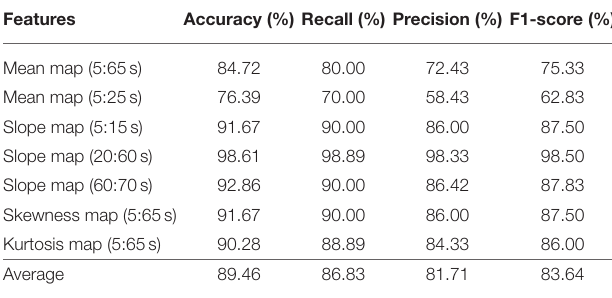
TABLE 7 | Convolutional neural network classification results of neuroimaging with temporal-spatial features for the N -back task. Features